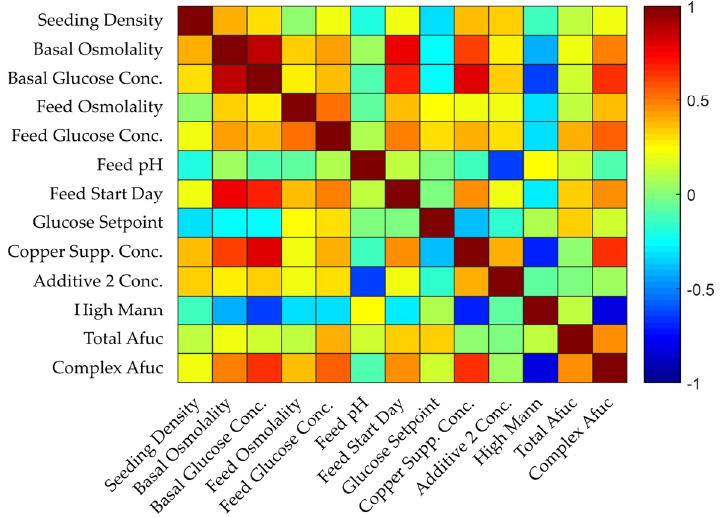
Figure 2. Correlation map between the cell culture parameters and afucosylation levels for mAb- δ .